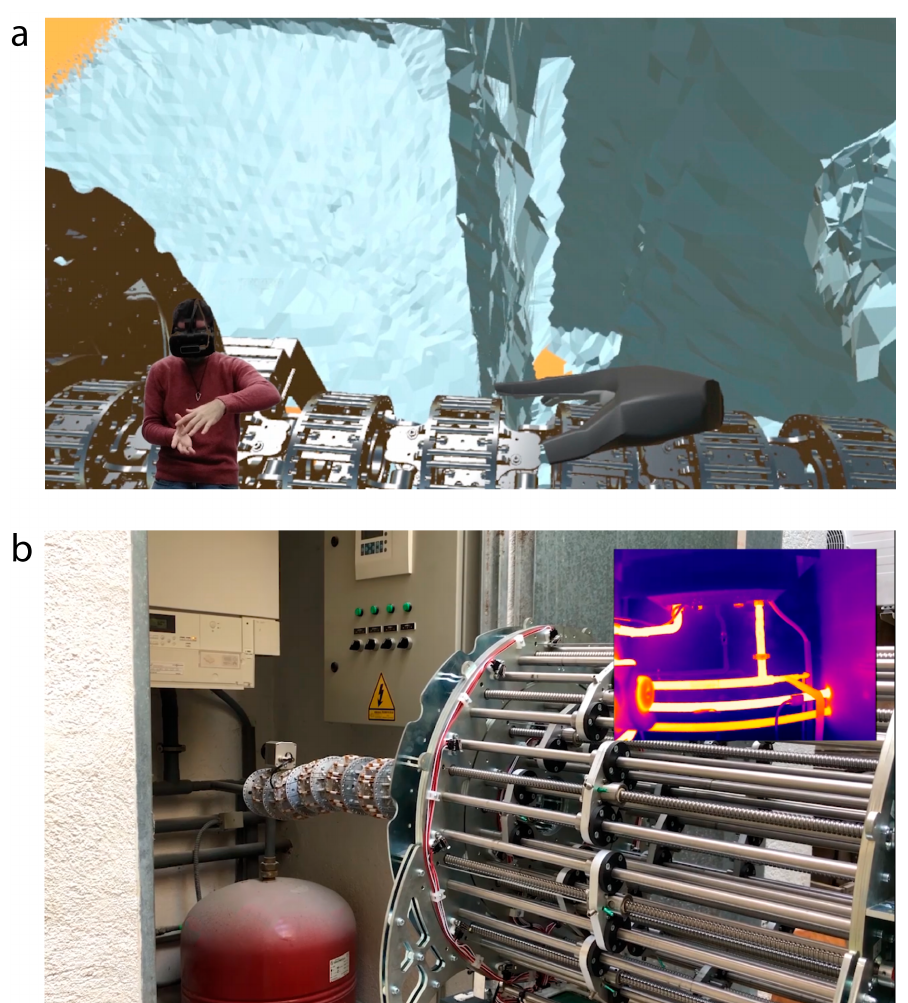
Figure 13. ( a ) The operator performs a shape control using his bare hands to interact with the virtual robot, a replica of the real one with the same kinematics and physical restrictions. ( b ) Using Mixed Reality, the real robot (slave) is moved to adopt the same pose as the virtual one (master). The thermal camera located in the end-effector let the operator supervise the temperatures of the boiler room from a safe and remote